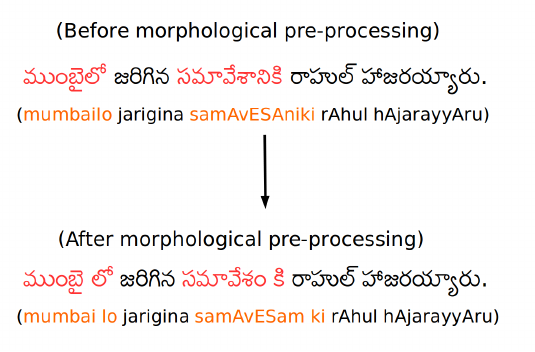
Figure 1. Morphological